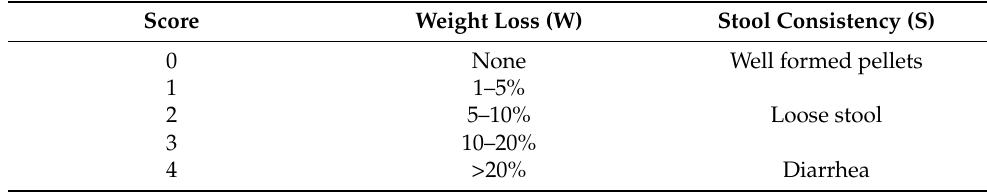
Table 1. Scoring of disease activity index (DAI) of DSS-induced colitis mice.